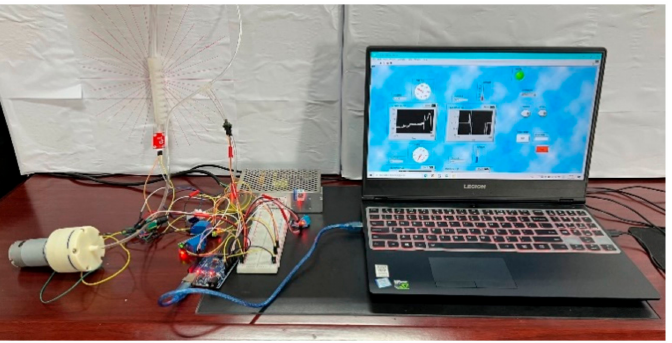
Figure 16. Experiment on the field test diagram of soft